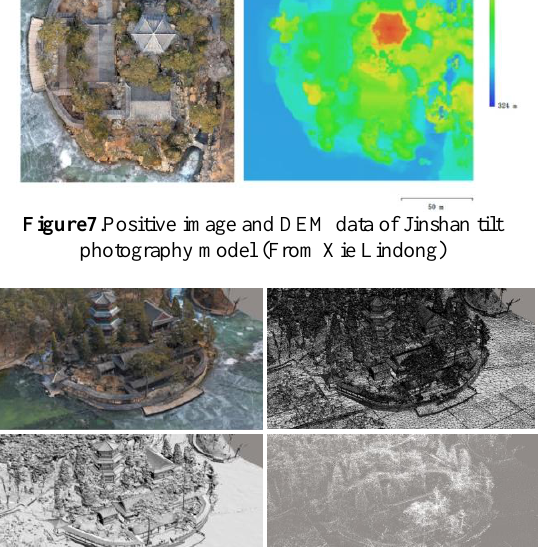
Figure 9 . The point cloud classification algorithm based on deep learning can remove the plants around the rockery. (From Xie Lindong)